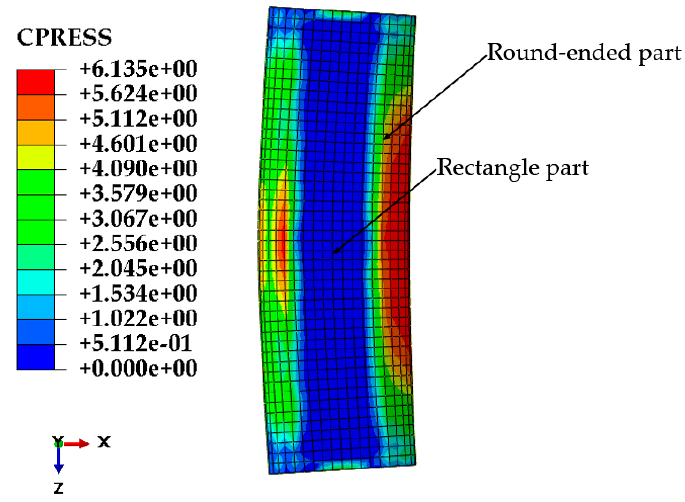
Figure 10. Interfacial stress of PY1-180-e1-Q235.